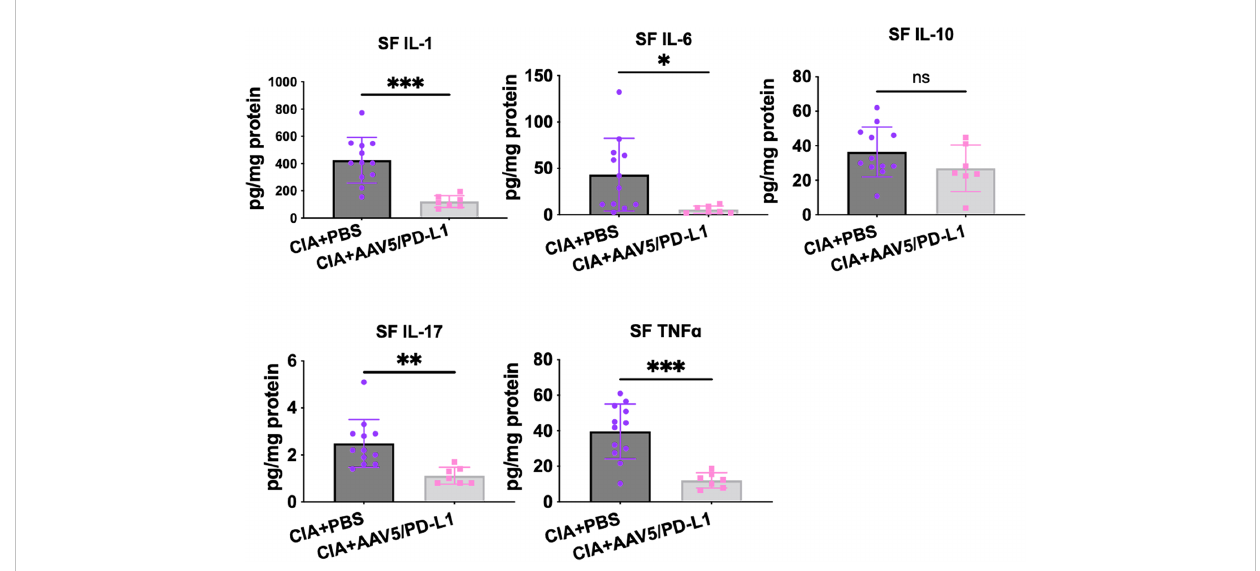
FIGURE 6 Reduced cytokines level in knee joints treated with AAV5/PD-L1 vectors. Knee joints were homogenized and the supernatant was collected for detection of cytokines IL-1, IL-6, IL17A, TNF a , and IL-10. Mean values are shown with standard derivation (n=12: PBS; n=7: AAV5/PD-L1). Data was